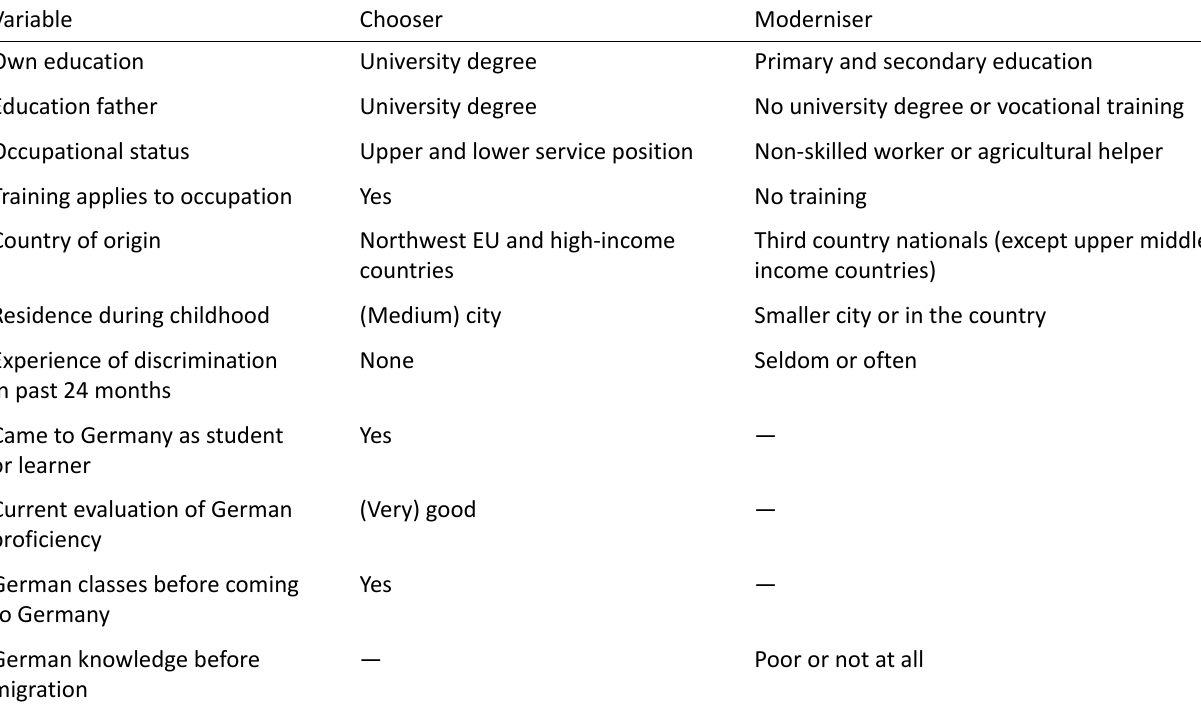
Table 1. Relevant variables from the SOEP data set for Chooser and Moderniser Index.